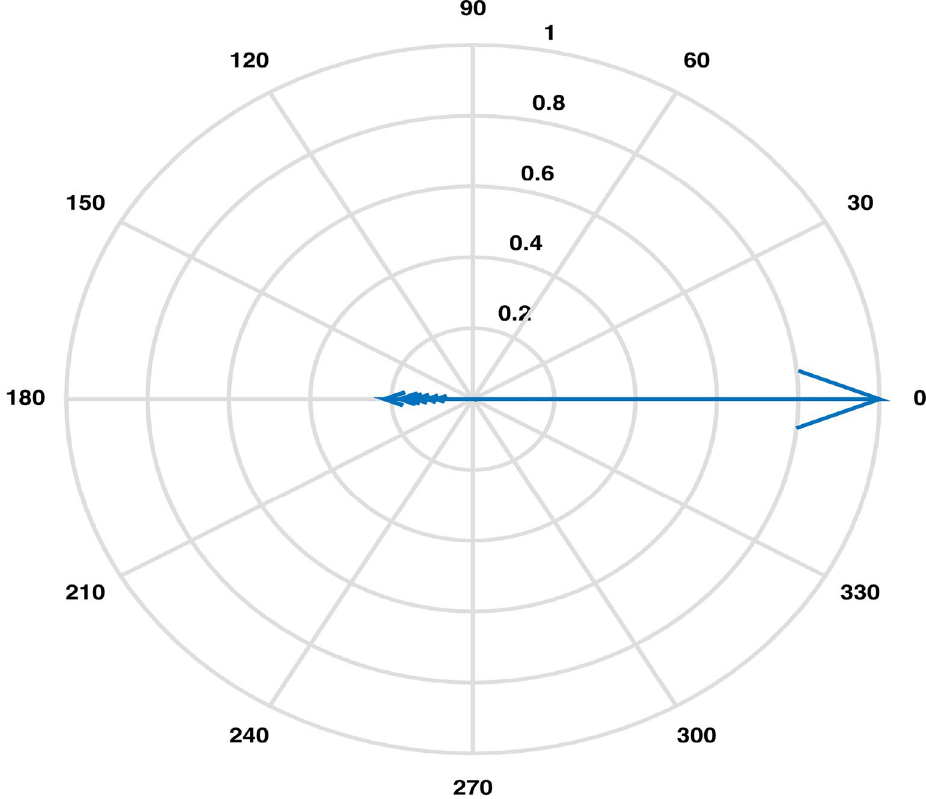
Figure 8. Pairwise correlations of E. Coli with other